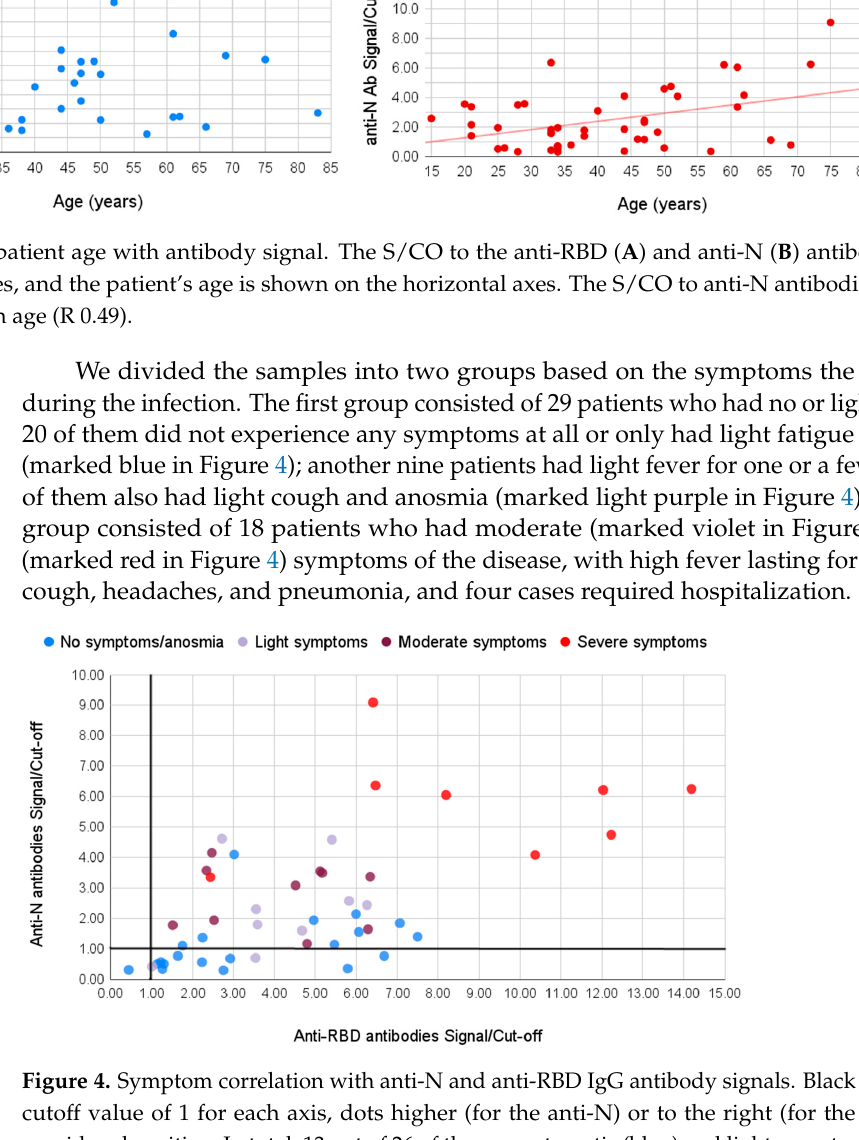
considered positive. In total, 13 out of 26 of the asymptomatic (blue) and light symptom (light purple)